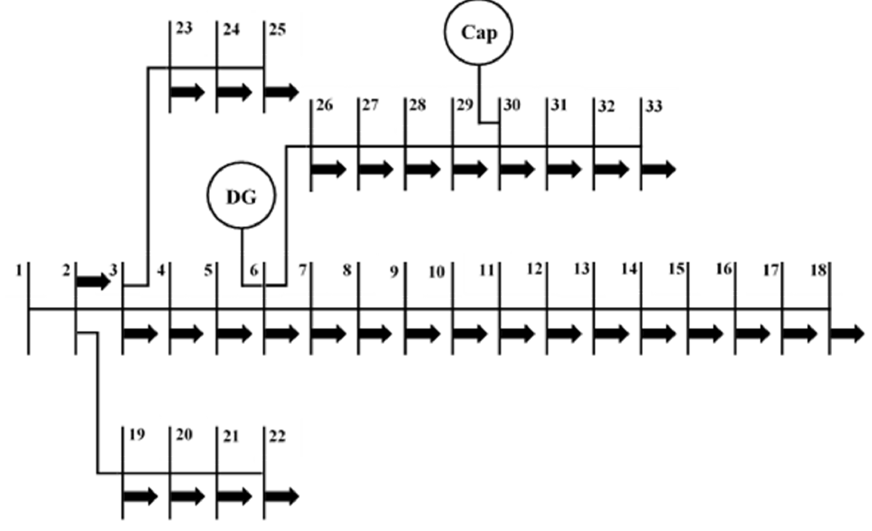
Figure 6. The 33-bus autonomous network with mounted DGs.